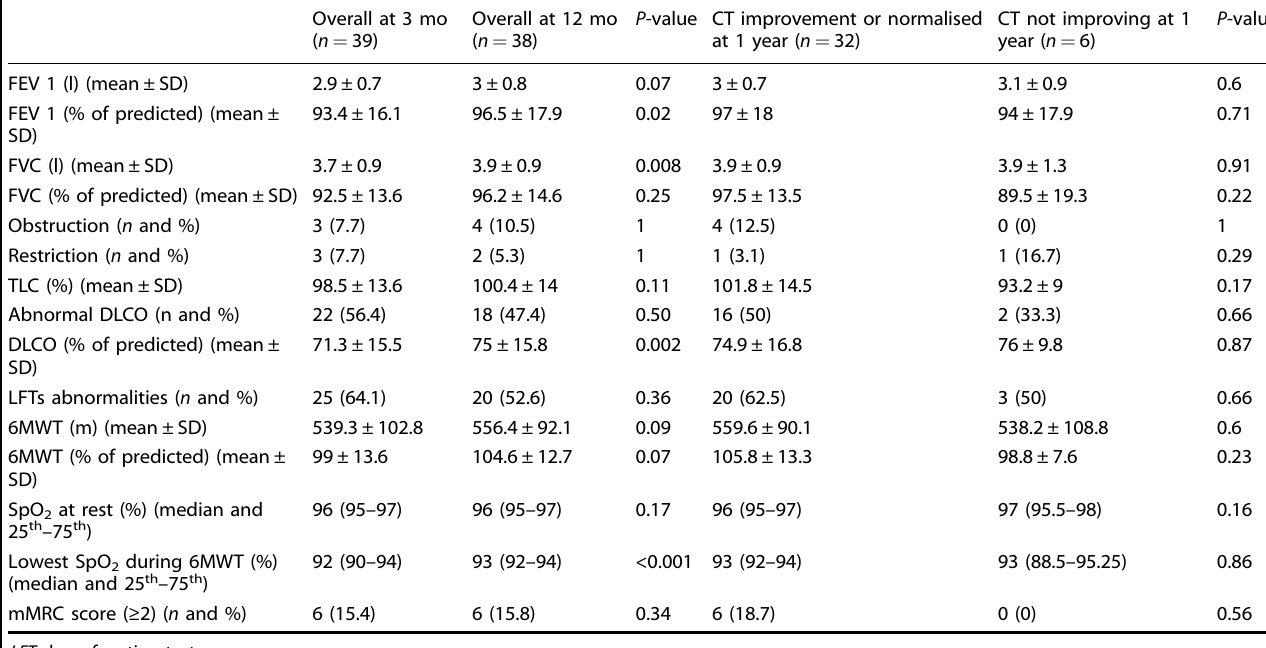
Table 4. Lung function tests and functional tests at three-month and 1-year follow-ups.